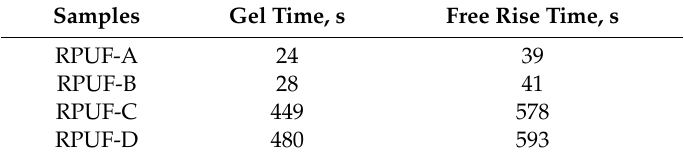
Table 2. The gel time and free rise time of the foaming process in di ff erent reaction conditions.